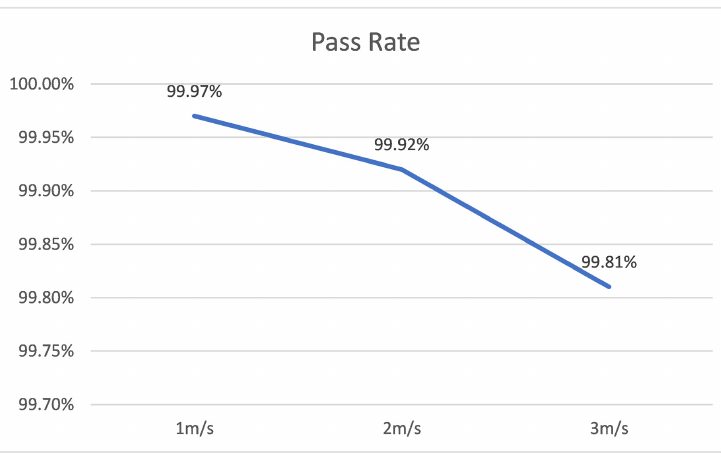
Figure 9. Relationship between Seeding Quality and Traction